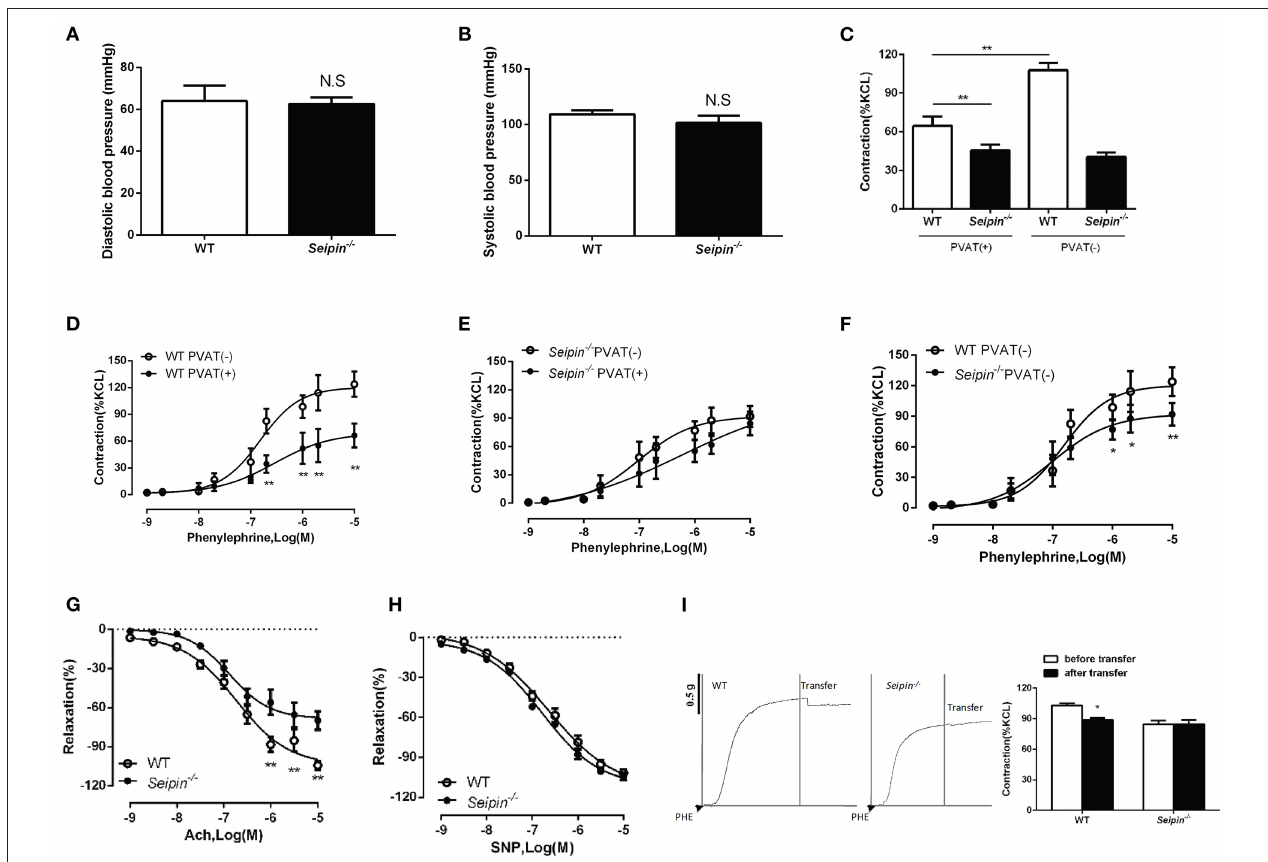
FIGURE 6 | Impaired vasoactivity in Seipin − / − mice. Systolic (A) and diastolic (B) of WT and Seipin − / − mice. N = 10. (C) Phenylephrine induced contraction of aorta rings with (+) or without (-) PVAT prepared from 6-month-old WT and Seipin − / − mice. (D, E, F) Phenylephrine dose-response curves of mesenteric artery rings with (+) or without (-) PVAT prepared from 6-month-old WT and Seipin − / − mice. (G, H) Endothelial-dependent relaxation with acetylcholine (Ach) and smooth muscle relaxation with sodium nitroprusside (SNP) in aortic rings prepared from 6-month-old WT and Seipin − / − mice. N = 10. (I) Representative curves of transferring 5mL incubation of aorta PVAT of WT and Seipin − / − mice to aorta without PVAT after preconstruction with phenylephrine (PHE, 10 uM). * P < 0.05, ** P < 0.01 for Seipin − / − mice vs.